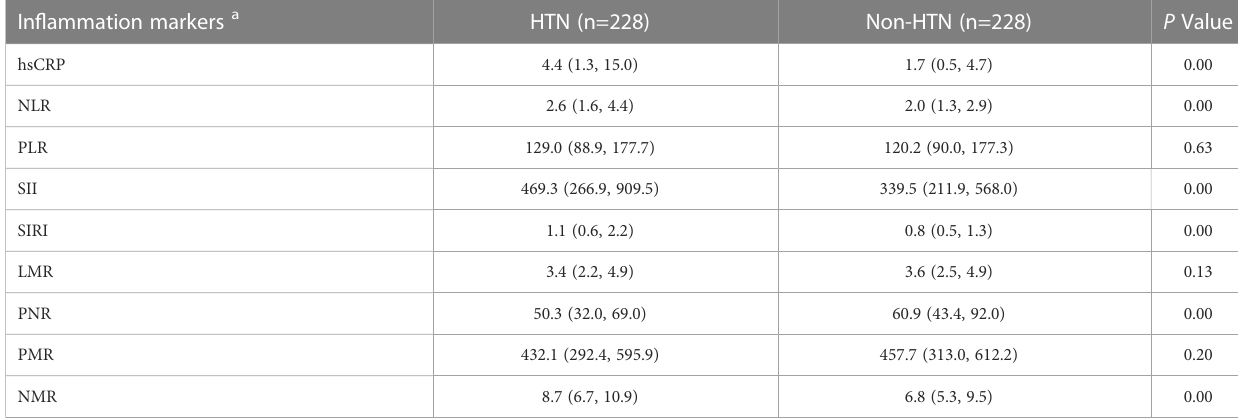
TABLE 3 In fl ammation markers of Patients in Both Groups. In fl ammation markers